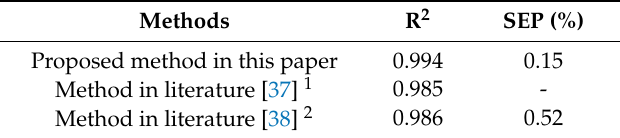
Table 4. The accuracy of the moisture content of rough rice measured by the proposed method versus methods of literature.